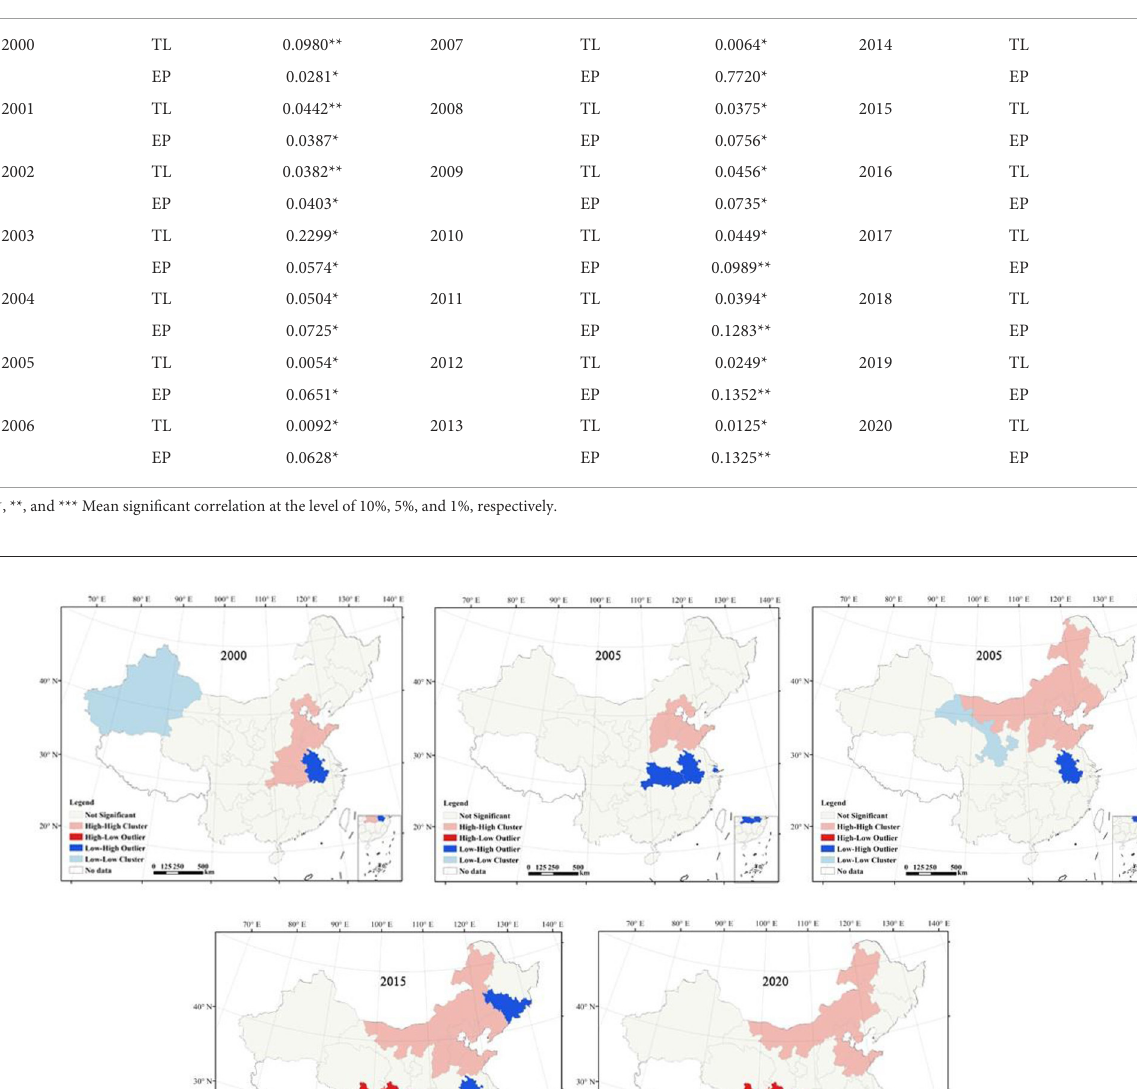
FIGURE1 LISA cluster diagram of EP in 2000–2020.